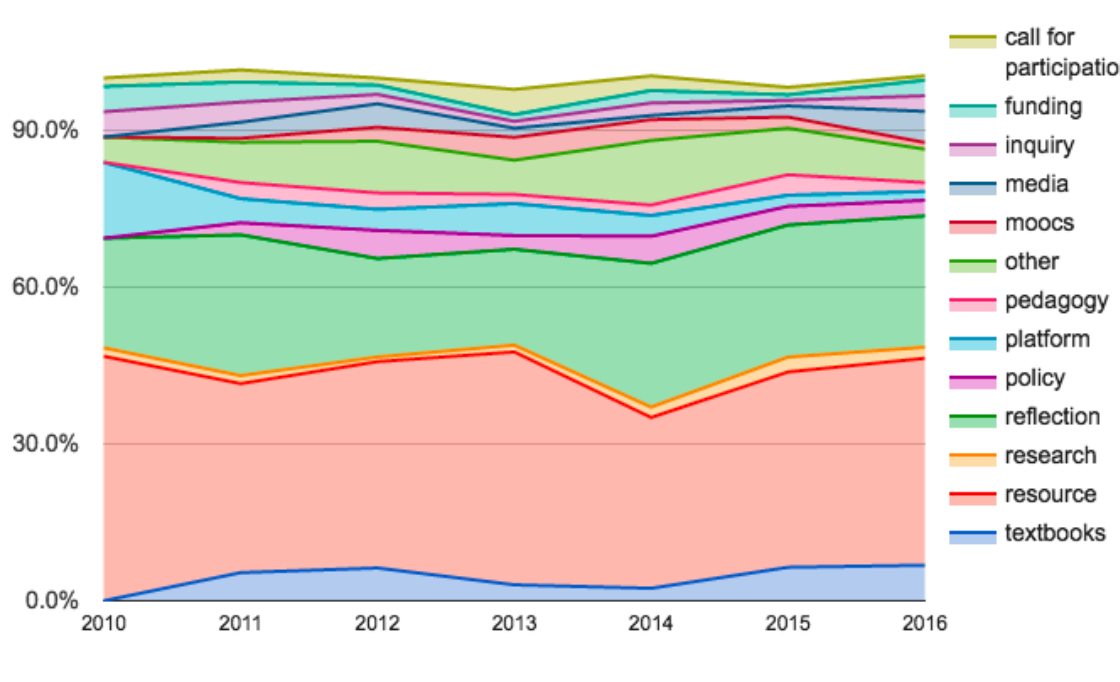
Figure 7. Qualitatively coded topics of tweets per